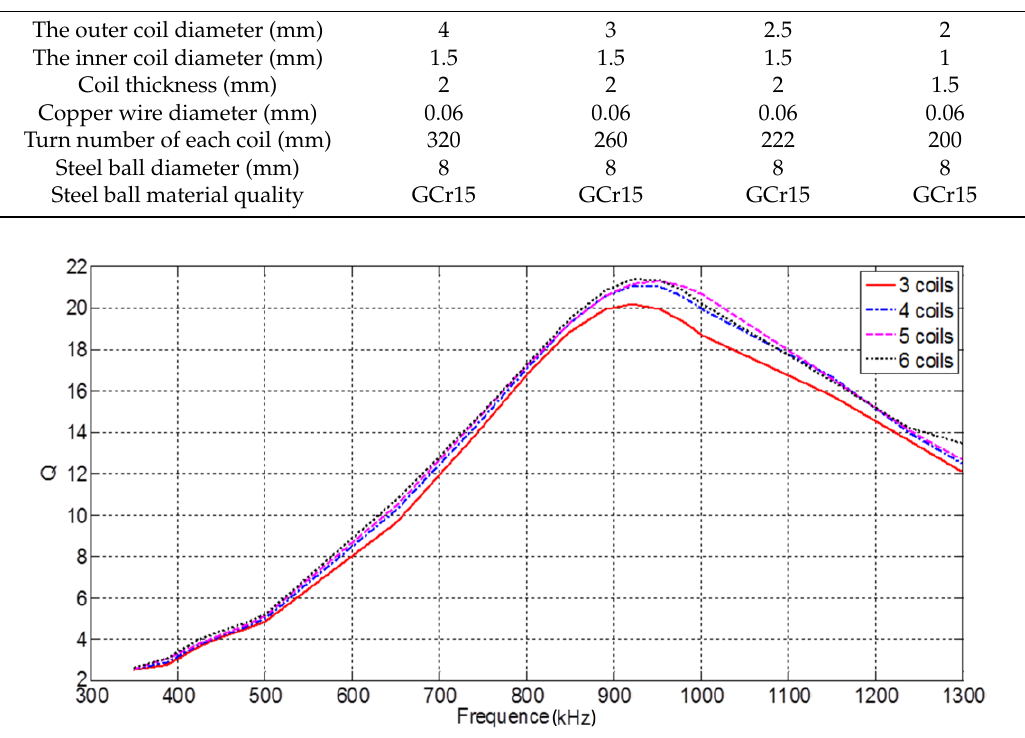
Figure 5. Q-factors of multi-coil probes with different excitation current frequencies. The Q-factor of a 3-coil probe in a CECA sensor reached a maximum of 20.1 at an excitation frequency of 920 kHz, but at 940 kHz, the Q-factor of 4-, 5-, and 6-coil probes reached the maximum,